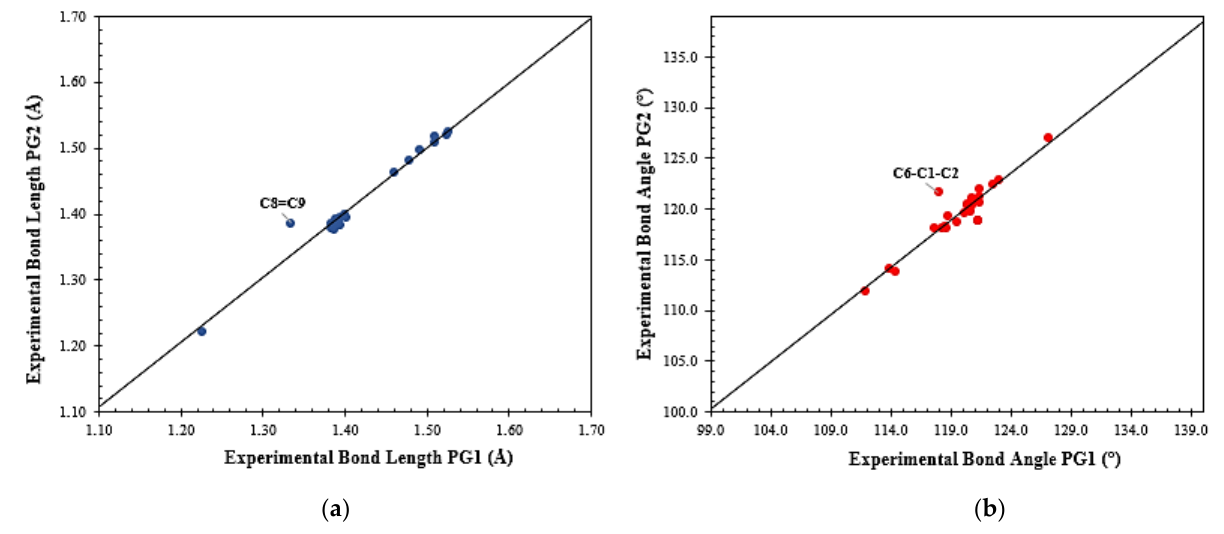
Figure 3. Scatter plots comparing experimental values of bond lengths ( a ) and bond angles ( b ) in BMP and BBP chalcones.